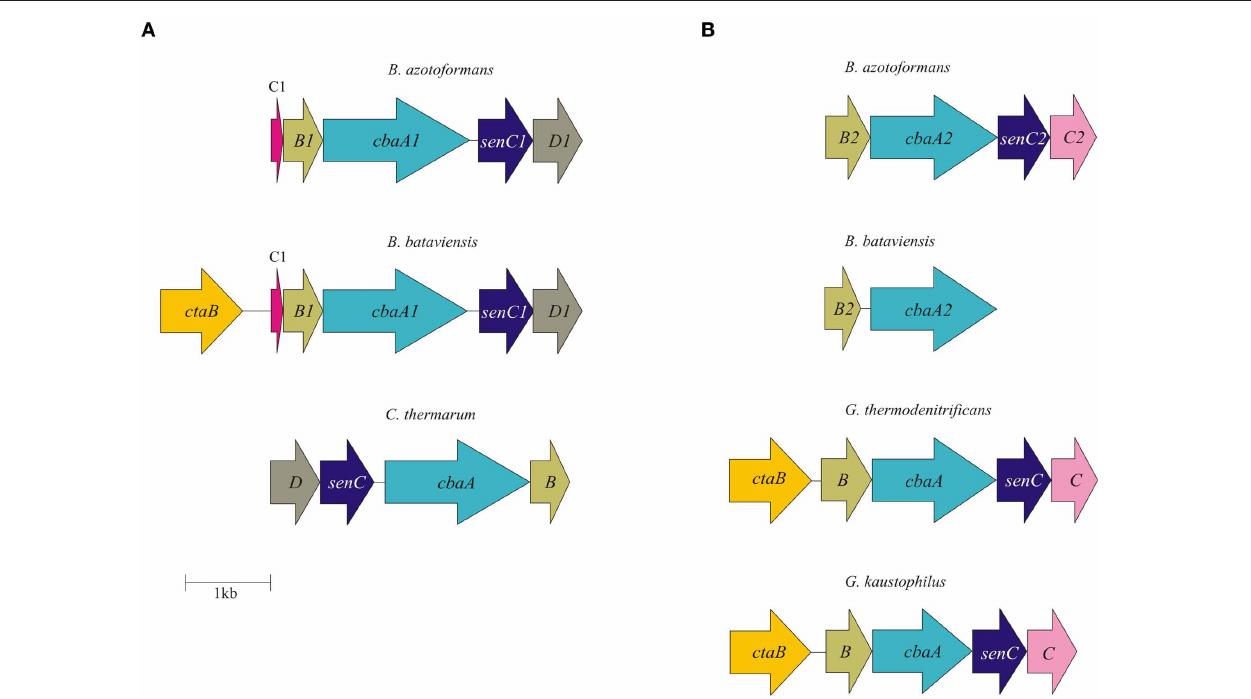
FIGURE 2 | Physical map of qCu A NOR type I (A) and qCu A NOR type II (B) gene cluster in B. azotoformans LMG 9581 T , B. bataviensis LMG 21833 T , Caldalkalibacillusthermarum TA2.A1, Geobacillus thermodenitrificans